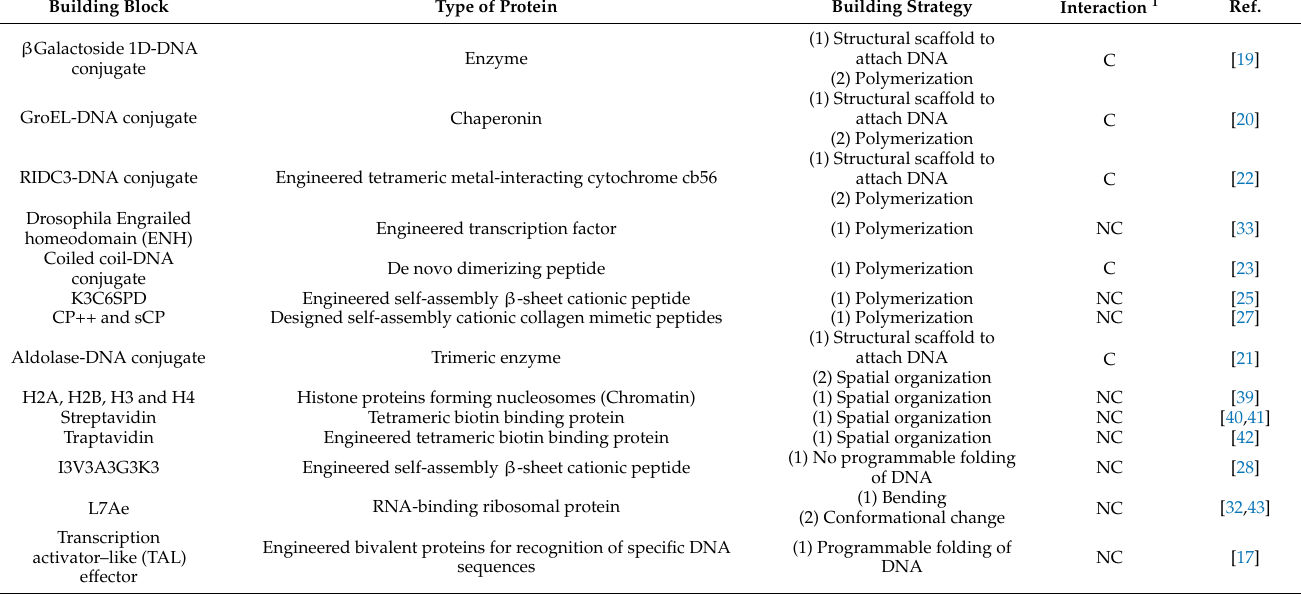
Table 1. Proteins used in structural protein–DNA